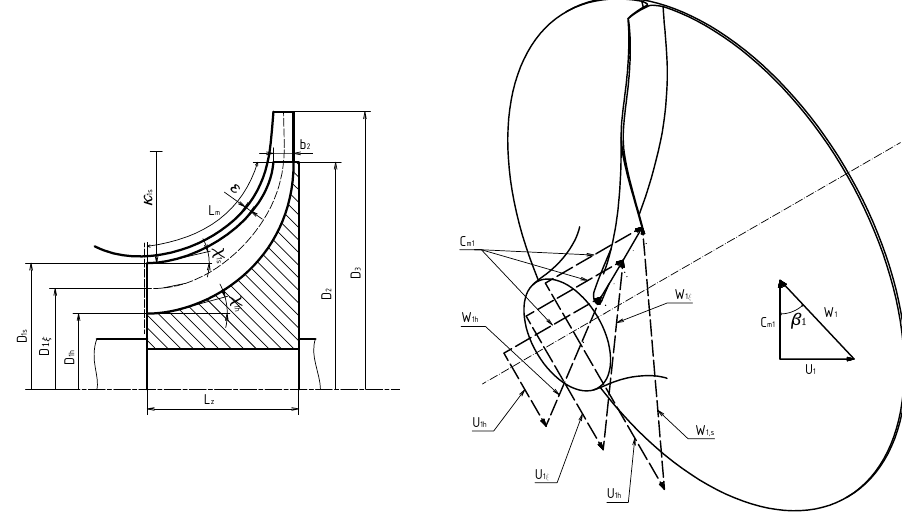
Figure 1. ( left ) Sketch of a centrifugal impeller with important dimensions in meridional cross-section; ( right ) example of velocity triangles along the height of impeller’s blade tip.